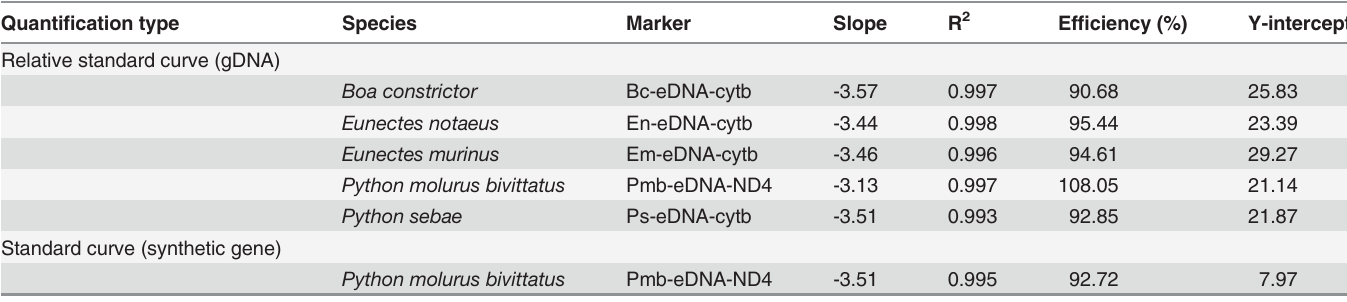
Table 2. Relative quantification (relative standard curve) values for five giant constrictor species using genomic DNA (gDNA) and absolute quanti- fication (standard curve) values for Python molurus bivittatus using a synthetic